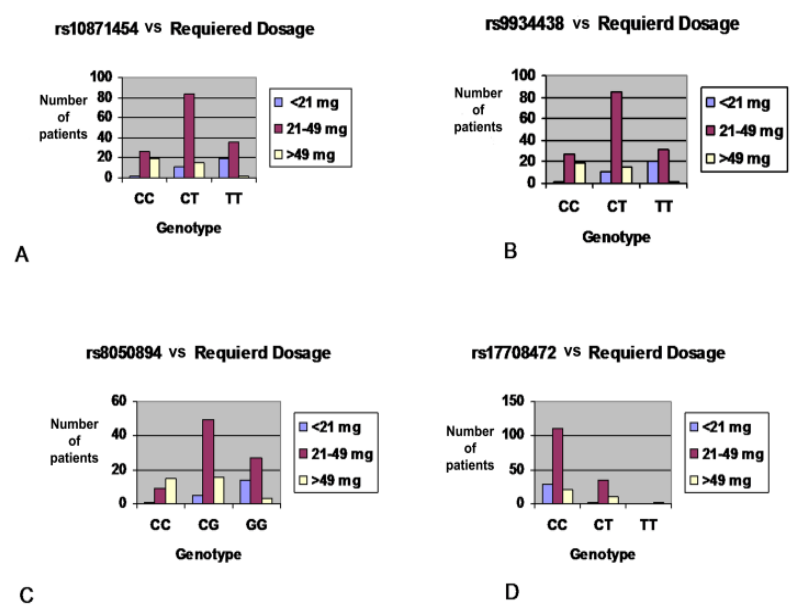
Figure 3. The distribution of warfarin dose by VKORC1 genotypes during the initiation phase of therapy for 212 Jordanian cardiovascular patients: X axis represents different VKORC1 genotypes, Y axis represents the proportion of patients across each genotype, Blue column represents a sensitive group who required the lowest warfarin dose (< 21 mg /week), Purple column represents the intermediate group who required moderate warfarin dose ((21 – 49) mg/week), Yellow column represents a resistant group who required the highest warfarin dose (> 49 mg/week). ( A ) Distribution of warfarin dose by rs10871454 variant. ( B ) Distribution of warfarin dose by rs9934438 variant. ( C ) Distribution of warfarin dose by rs8050894 variant. ( D ) Distribution of warfarin dose by rs17708472 variant. For the last VKORC1 SNP VKORC1 *4 C<T (rs17708472), our study is similar to the study by Haug